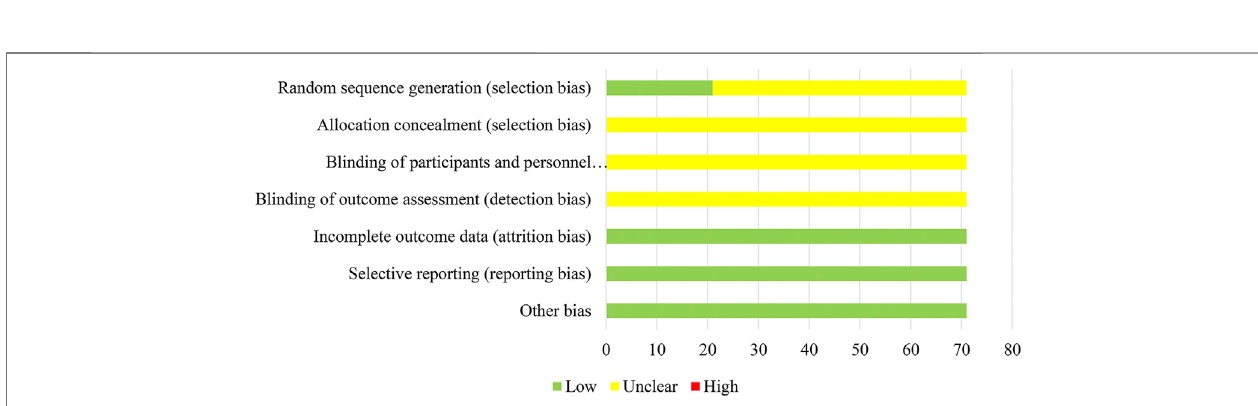
FIGURE 3 | Network graph for different outcomes. (A) Clinical effectiveness rate; (B) Performance status; (C) Leukopenia; (D) Gastrointestinal reactions; (E) Thrombocytopenia; and (F) Abnormal liver function. Note: ADI, Aidi injection; CKSI, Compound Kushen injection; DLSI, Delisheng injection; GP, Gemcitabine plus Cisplatin; JOEI, Javanica oil emulsion injection; KAI, Kangai injection; KLTI, Kanglaite injection; SMI, Shenmai injection; SQFZI, Shenqifuzheng injection; and XAPI, Xiaoaiping injection.